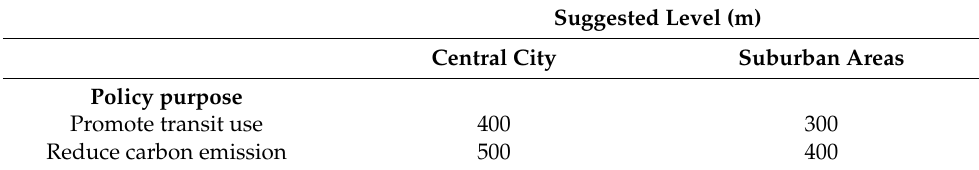
Table 5. Impact boundary of bus